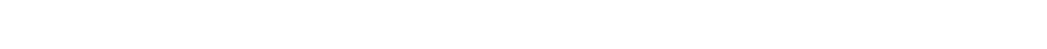
Frontiers in Endocrinology |